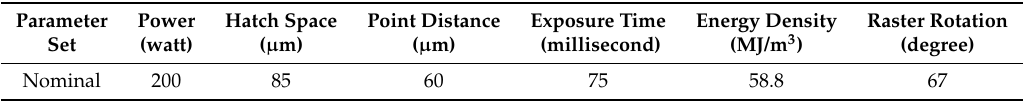
Table 2. Parameters used to build additively manufactured part using selective laser melting (SLM)